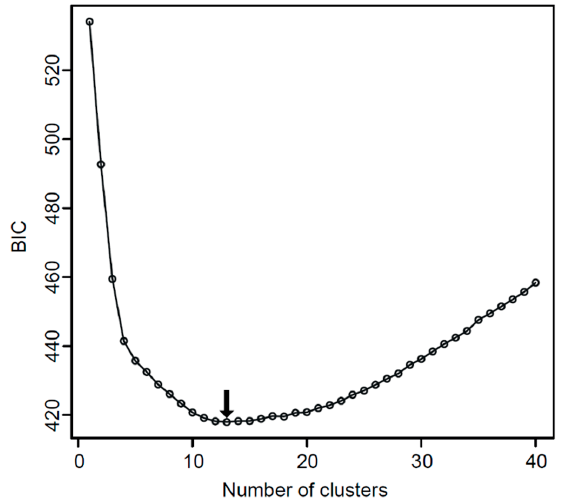
Figure 4. The BIC scores for the k-mean cluster analysis computed with PCs describing >99.0% of total variance. The lowest score (black arrow) indicates the best fitted model to describe clusters within the morpho data set.